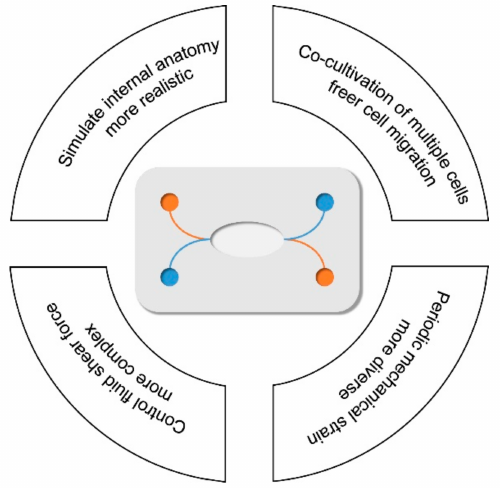
Figure 2. Four main advantages of microfluidic